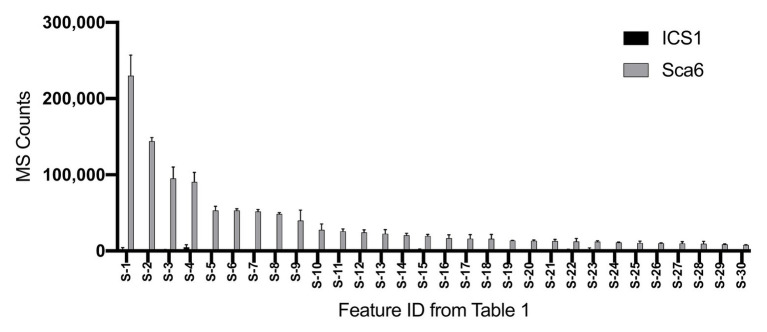
Relative abundance of the 30 most abundant features in ‘Sca6’ of those >5-fold higher than in ‘ICS1’ (p < 0.05). Feature IDs (S-1 through S-30) match those in Table 1. MS counts represent mass spectrometer signal intensity of peaks integrated in XCMS Online (Tautenhahn et al., 2012). Error bars represent standard deviation. n = 3.